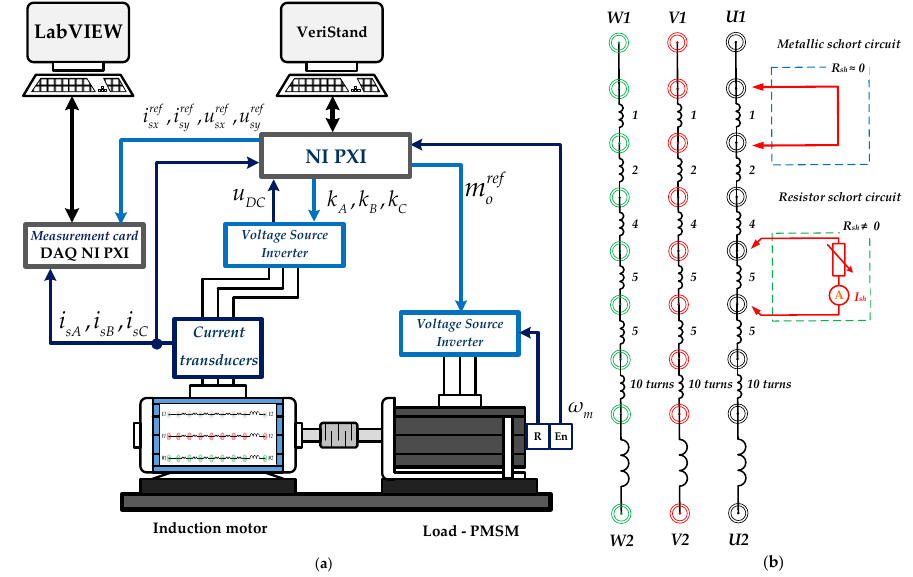
Figure 4. ( a ) Block diagram of the experimental setup and ( b ) the diagram of the induction motor terminals and modelled short circuit without (above) and with (below) additional resistor and ammeter.